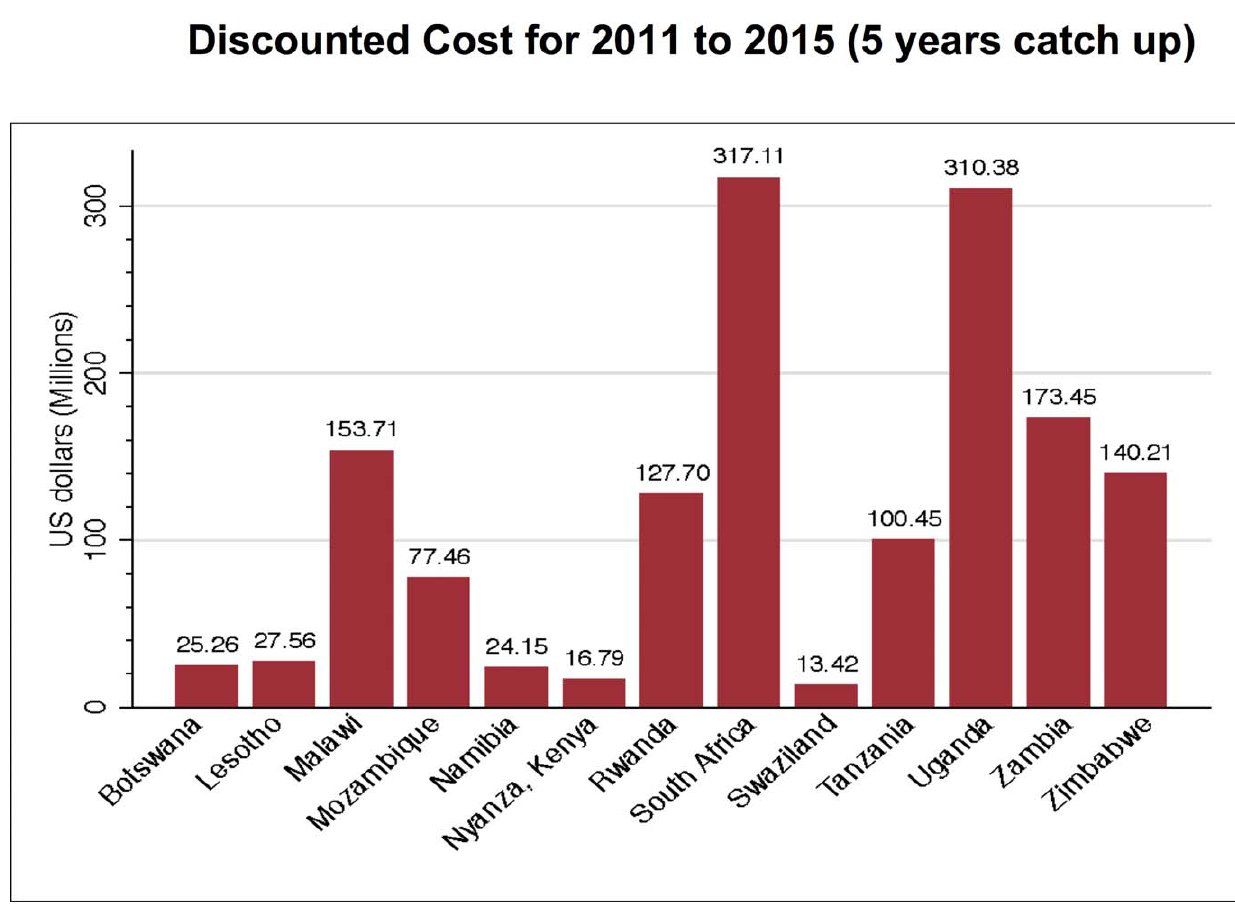
Figure 3. Cost for scaling up VMMC coverage in base case, by country, 2011–2015. Figure 3 provides the discounted cost of scaling up VMMC coverage for 2011–2015 for the base case scenario in which 80% coverage of VMMC is reached in 2015 and maintained thereafter, and there is no post-circumcision risk behavior change.